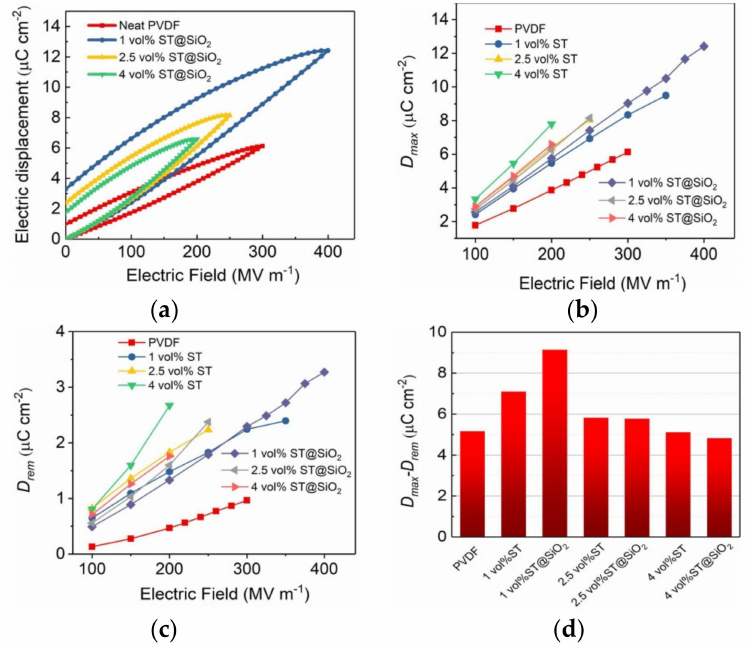
Figure 6. ( a ) Unipolar D–E loops at breakdown strengths. ( b ) Maximum displacement. ( c ) Remnant displacement and ( d ) electric displacement difference of PVDF and composites as a function of platelets content measured at varied electric